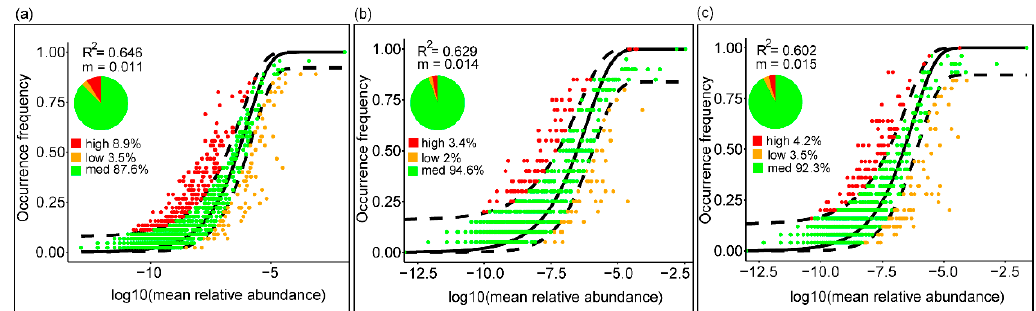
Figure 6. Fit of the neutral model for microbial community. The predicted occurrence frequencies for ( a – c ) bacterioplankton communities representing all, free-living and particle-associated samples, respectively. ASVs that occur more frequently than predicted by the model are shown in red while those that occur less frequently than predicted are shown in orange. Dashed lines represent 95% confidence intervals around the model prediction (black line).